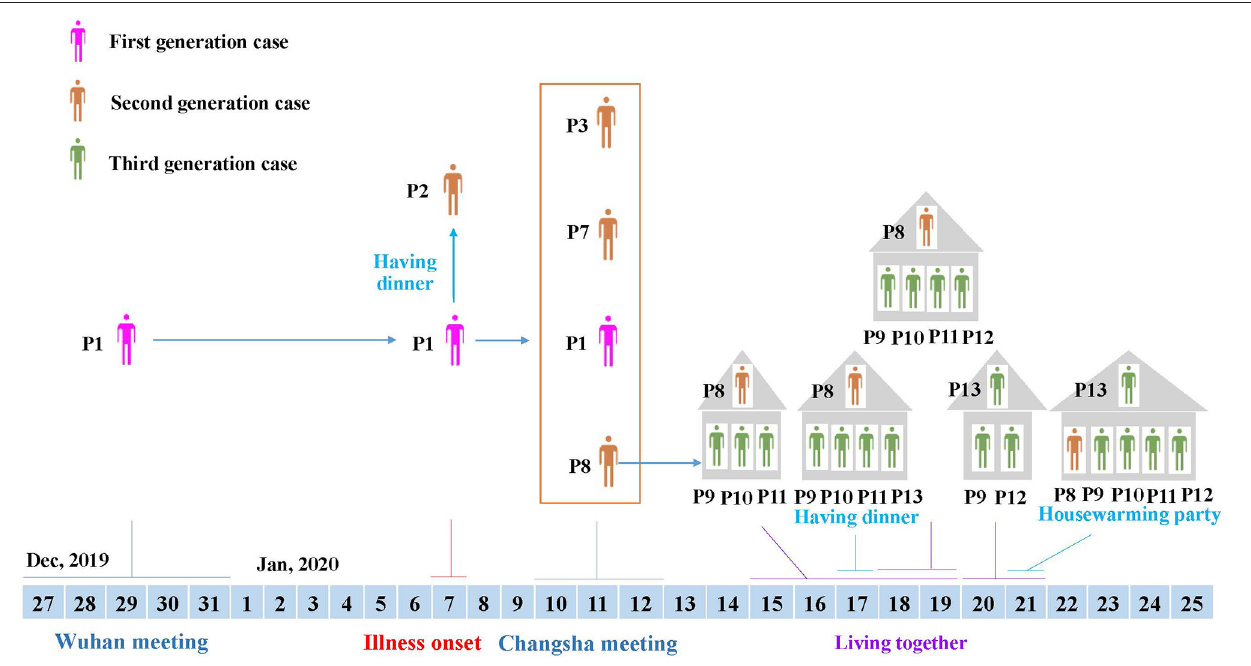
FIGURE 2 | Transmission linkage of the patients. Different colors of individuals indicate the first to third generation cases. Patient 1, the first-generation case identified, was from Huaihua City, and had travel history to Wuhan, where she attended a large conference from December 27 to 31, 2019. After returning home, she developed respiratory symptoms on January 7, 2020, and transmitted the virus to four second-generation cases during a dinner (Patient 2) and meeting (Patient 3, Patient 7 and Patient 8). Then, Patient 8 from Shaoyang City transmitted the virus to her relatives through close contact, resulting in third-generation cases (Patient 5, Patient 9, Patient 10, Patient 11, Patient 12, and Patient